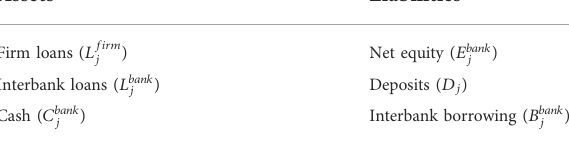
TABLE 1 The balance sheet of bank j